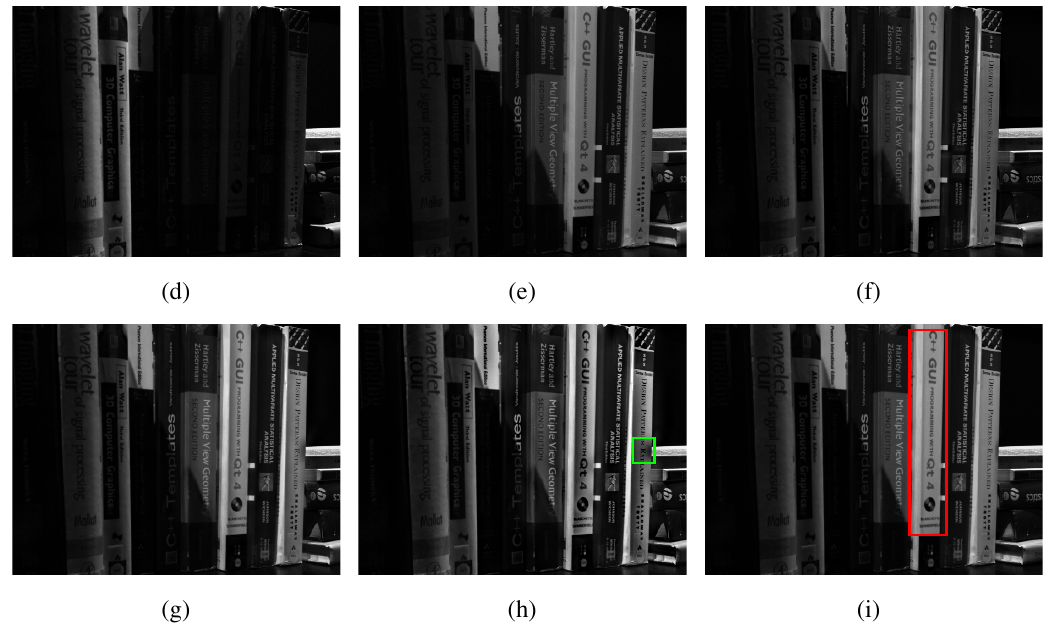
Figure 8. Multi-exposure image fusion results for Dataset 2. ( a ) Image 1; ( b ) Image 2; ( c ) Image 3; ( d ) Image 4; ( e ) PCA; ( f ) DWT; ( g ) NCT-S; ( h ) NCT-N; ( i )